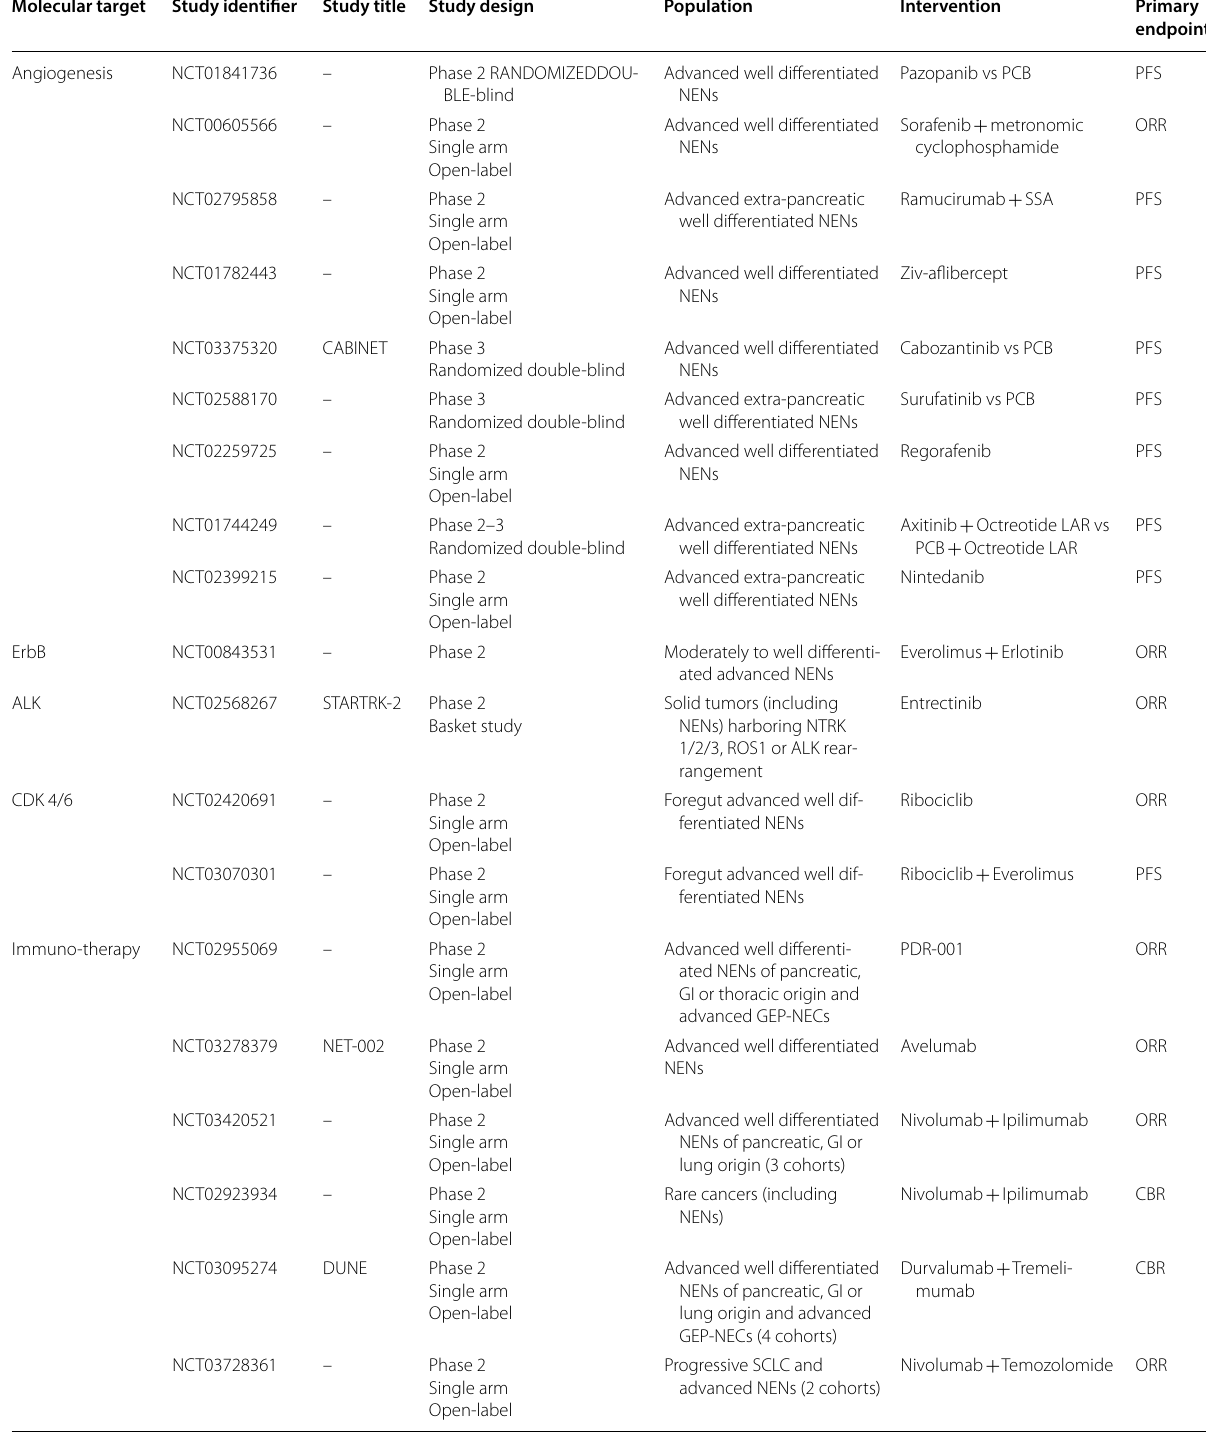
Table 2 Ongoing clinical trials evaluating potential therapies in lung